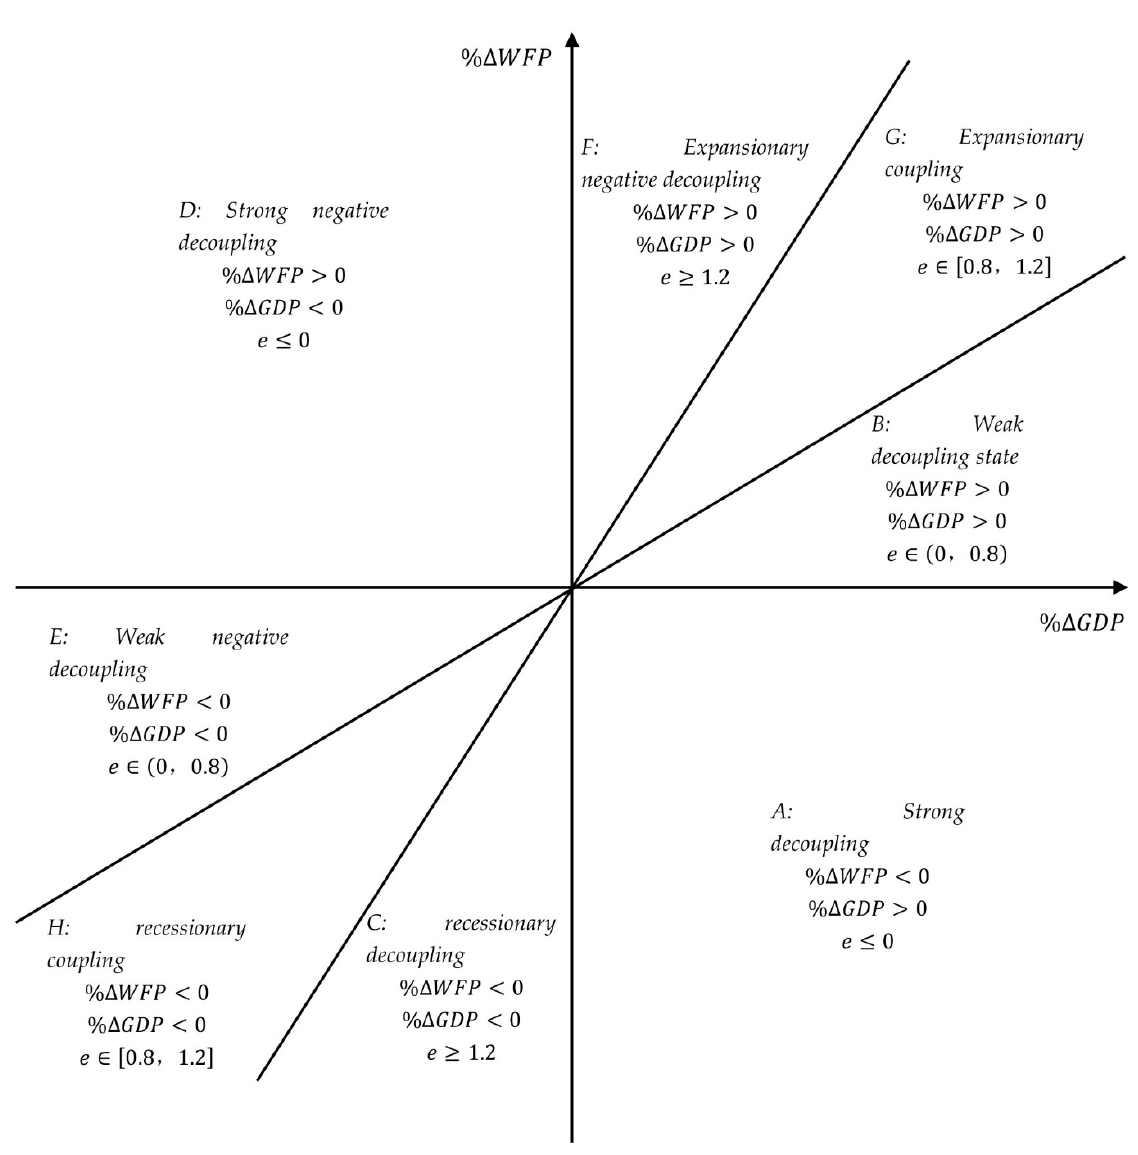
Figure 1. Schematic diagram of the decoupling relationship between water resources utilization and economic development in the region.